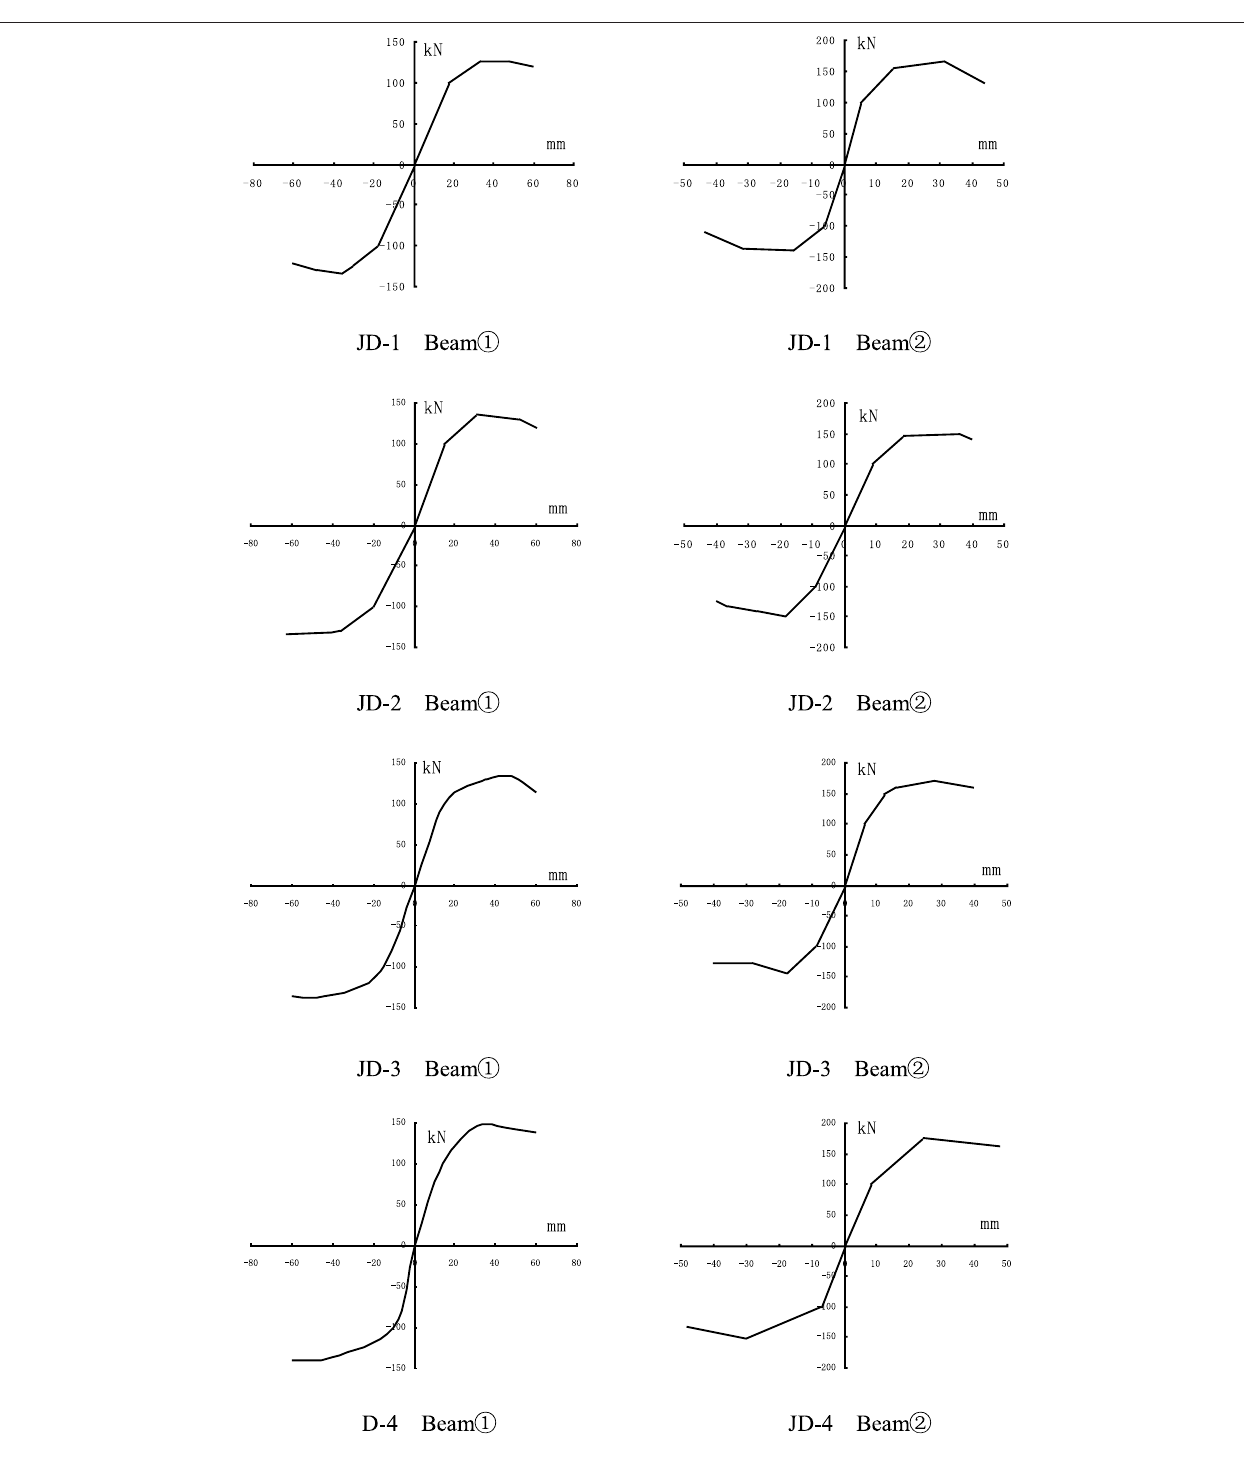
FIGURE 19 | Skeleton curve of hysteretic loop of load and de fl ection at beam end.